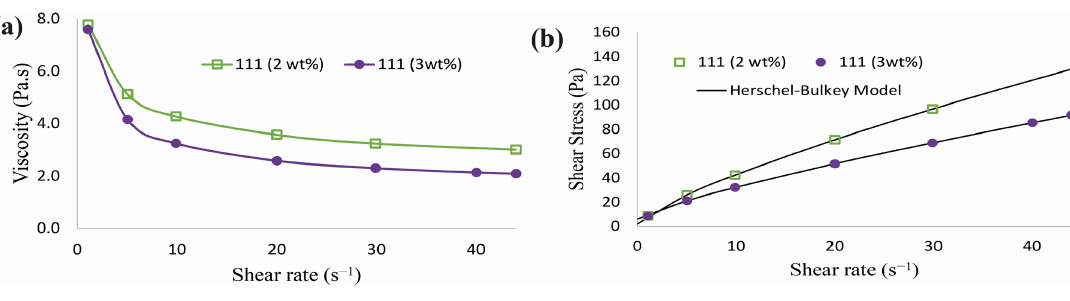
Figure 5. Rheological behavior of 40 vol% solid loading ceramic slurries. (a) Viscosity curve with different monomers; (b) Shear stress vs shear rate with different monomers fitted by the Herschel-Bulkley model.